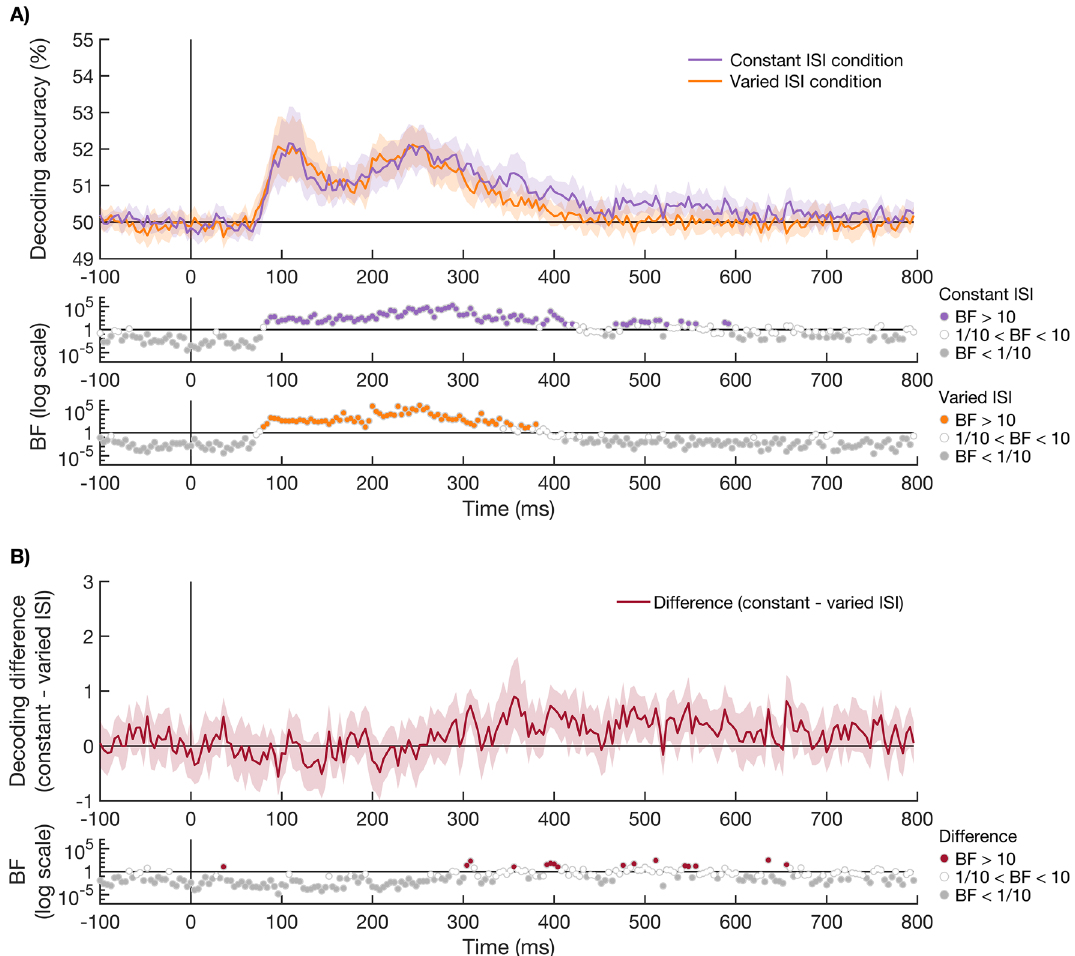
Figure 3. Time-course of decoding accuracies of the orientations presented at a constant and varied ISI. ( A ) shows orientation decoding accuracy of stimuli presented at a constant ISI (purple) or varied ISI (orange). Plotting conventions are the same as in Fig. 2. The orientations of stimuli presented at a constant ISI or varied ISI could be decoded from 88 and 84 ms after stimulus onset respectively. ( B ) shows the effect of temporal expectation, measured as the difference in orientation decoding between the stimuli presented at a constant or varied ISI (constant − varied ISI). The BFs are given below the plot on a log scale. There was no effect of temporal expectation on the coding of orientation information. A few time-points after 300 ms showed stronger orientation coding for the constant compared to varied ISI conditions, but the Bayes factors for most time-points in the 300 ms to 800 ms time-window either suggested inconclusive evidence or evidence for no compared to uncued features and/or objects 36,37,39 . In line with our previous work 39 , we show that these effects are not contingent on confounding stimulus and decision. The current study builds on previous findings by showing that feature-based attention effects occur even when we control for target-related processing and ensure that decisions do not confound the stimulus classification, and that they occur regardless of whether the stimulus onset timing is expected or not. One difference with previous research is how long the cued information was